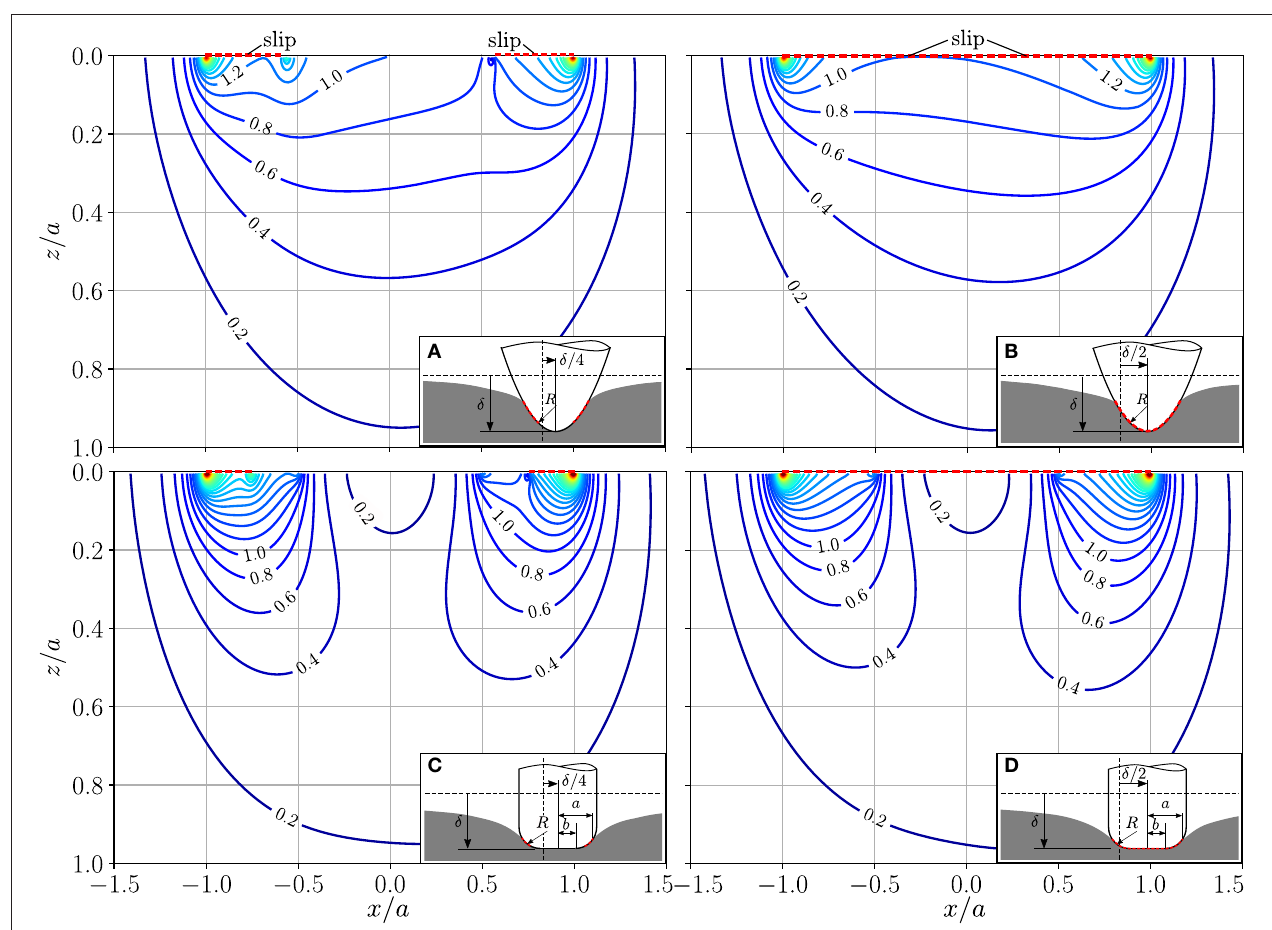
FIGURE 4 | Normalized absolute value of the hydrostatic pressure gradient at y with indentation depth δ and tangential displacement u x ,0 punch with rounded edge with b / a